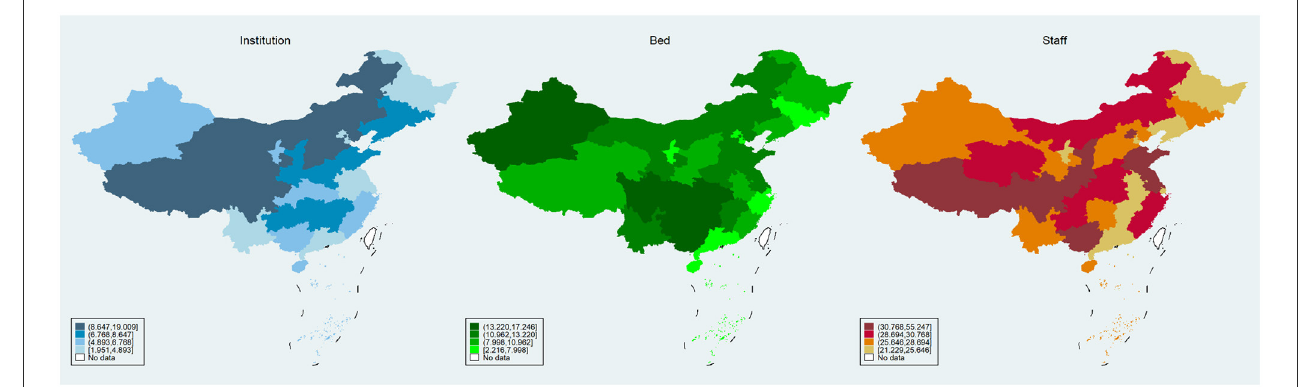
FIGURE1 Distribution of provincial primary medical and health preparedness. (Left, middle, and right) Show the distribution of PMHIs (number per 10,000 people, the number of beds in PMHIs per 10,000 people, and the number of staffs in PMHIs per 10,000 people, respectively).